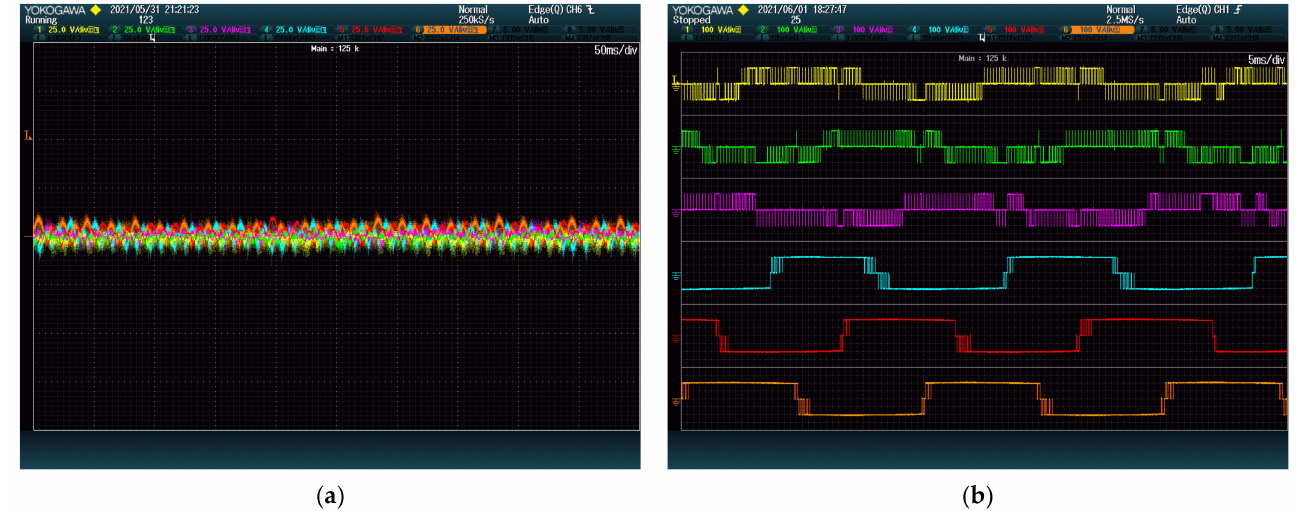
Figure 9. Sixth test results, each phase contains one module with ripple penalization ( G Pk 1 = 0.1) and another with switching penalization ( G Sk 2 = 0.1 ): ( a ) DC-link voltage ripple (25 V/dv) vs. time (50 ms/div); ( b ) Modules output voltages for 2.5 grid periods.